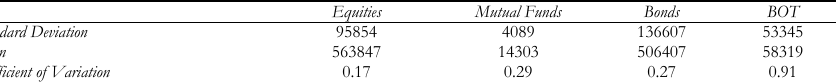
Coefficients of Variation of Italian households’ asset holdings The Table reports the coefficients of variation ( σ / µ ) of some financial assets (1995-2007). Our elaboration based on FA data